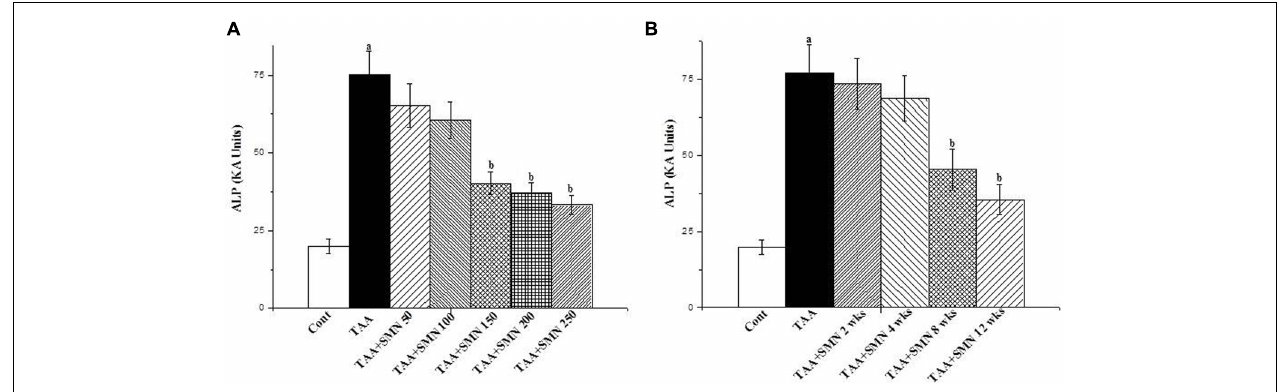
FIGURE 1 | (A) Representation of the dose dependent study of SMN on ALP level in TAA-treated pathophysiology in the serum of the experimental mice. Cont: measurement of serum ALP in normal mice, TAA: measurement of serum ALP in TAA administered mice, TAA + SMN 50, TAA + SMN 100, TAA + SMN 150, TAA + SMN 200, and TAA + SMN 250: measurement of serum ALP in mice which are treated with SMN at a dose of 50, 100, 150, 200, and 250 mg/kg body weight, orally, respectively, after TAA administration at a dose of 100 mg/kg body weight, i.p. (B) Representation of the time dependent study of SMN on ALP activity in TAA-exposed pathophysiology in the serum of the experimental mice. Cont: measurement of serum ALP in normal mice, TAA: measurement of serum ALP in TAA exposed mice, TAA + SMN 2 week, TAA + SMN 4 week, TAA + SMN 8 week, and TAA + SMN 12 week: measurement of serum ALP in mice which are treated with SMN at a dose of 150 mg/kg body weight, orally for 2, 4, 8, 12, and 16 weeks, respectively. “a” indicates the significant difference between the normal control and TAA exposed groups, “b” indicates the significant difference between TAA exposed (toxin control) and SMN post-treated groups. Each column represents mean ± SEM, n = 6; ( p a < 0.05, p b <